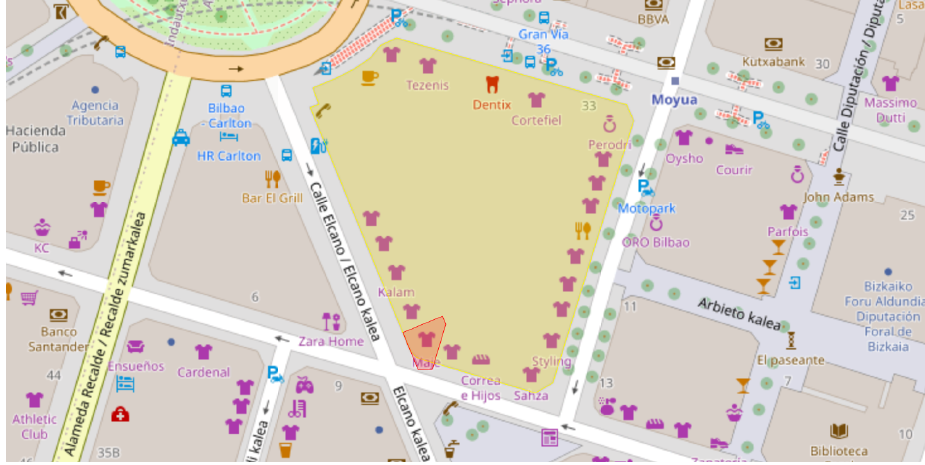
Figure 26. Again the calculated limits are subtracted. Finally, the edge of the building is subtracted from the building (see Figure 27).